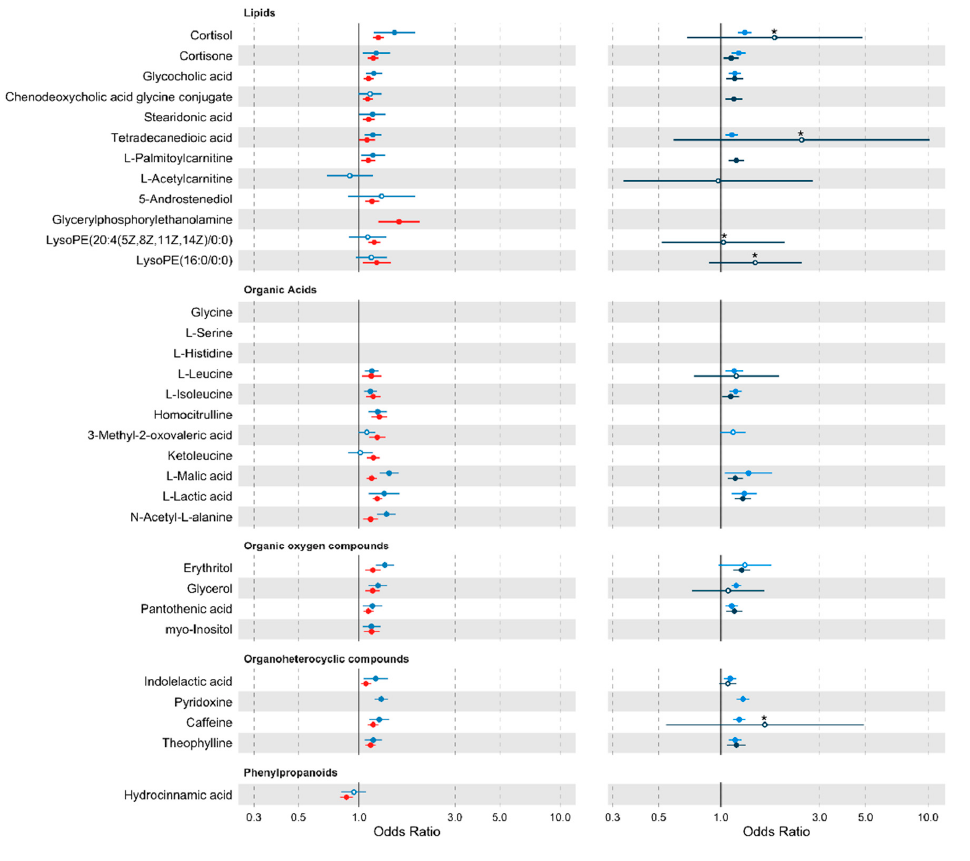
Figure 3. Forest plot of traditional risk factor adjusted analyses stratified by sex, and ethnicity. Metabolites are grouped by class. Points represents odds ratio (OR), and tails show the 95% confidence interval (CI). For an improved scale, associations with an upper CI > 3 have been truncated, reducing the standard error by 2.5 times, and are identified by a * above the OR point. For true values see Supplementary Figure S2. Metabolites not passing an α level of 0.05 are shown with a white point. Metabolites where there were fewer than 2 cohorts with the metabolite detected in >80% of the stratified sample are